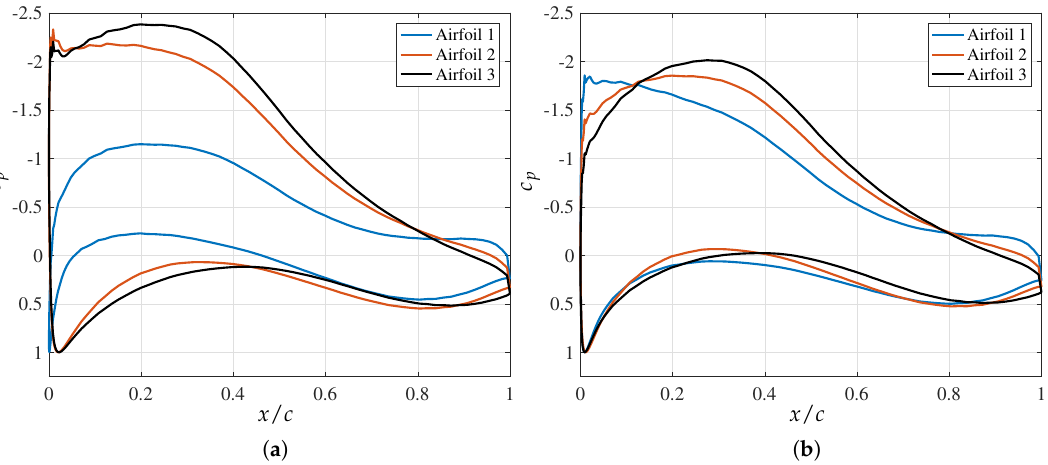
Figure 6. The pressure coefficient graphs for the airfoils 1 , 2 and 3 presented in Figure 5. The graphs in ( a , b ) show the pressure coefficients when the airfoils are simulated at their own operating conditions (described in Figure 5’s caption) and the reference operating conditions (Re = 10 6 , AOA = 5 ◦ ),